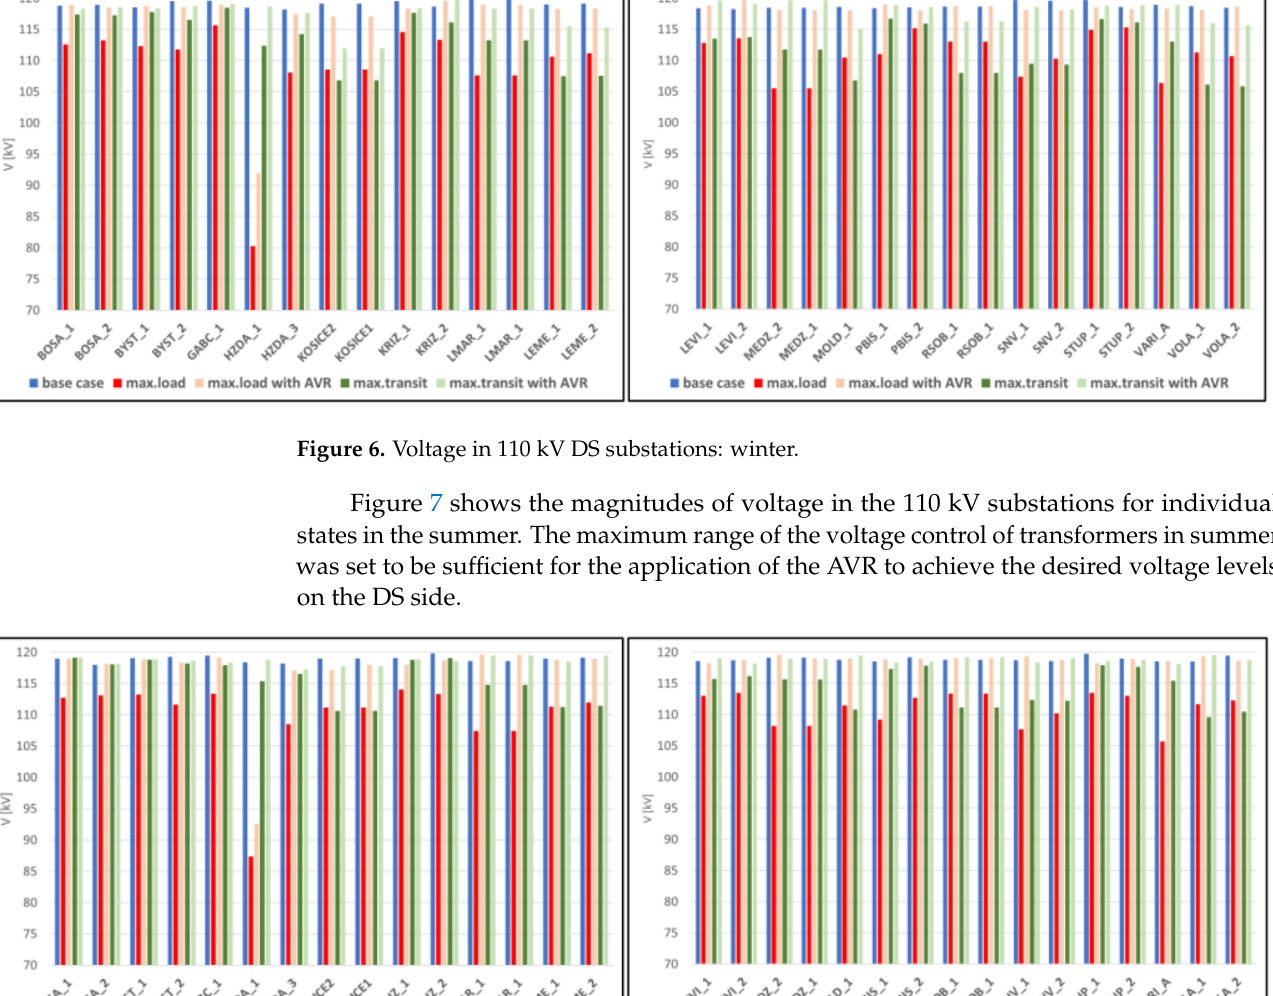
Figure 5. Voltage in 400 kV TS substations: winter (left), summer (right).